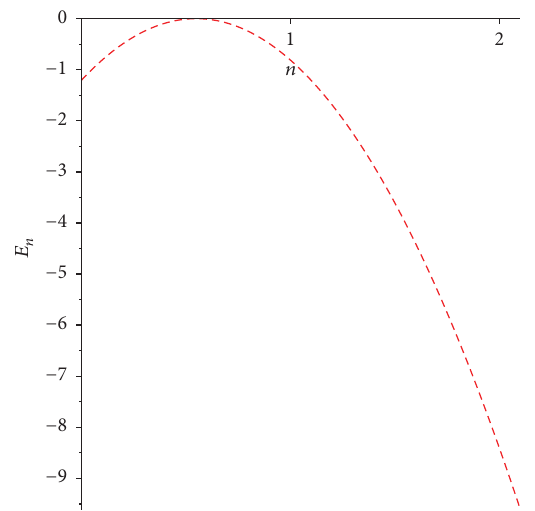
Figure 1: The variations of energy versus 𝑛 with V 1 = 0.09 , V 3 = 10 , and 𝑔 = 1/4 .